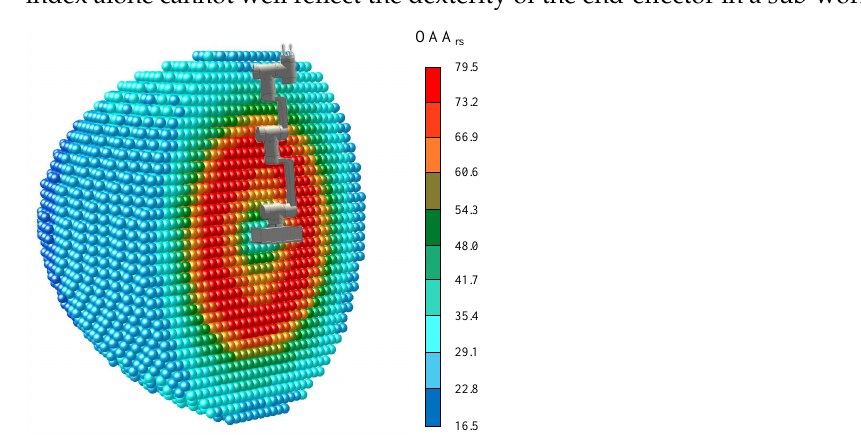
Figure 11. The obstacle avoidance ability index of all reachability spheres in the workspace.